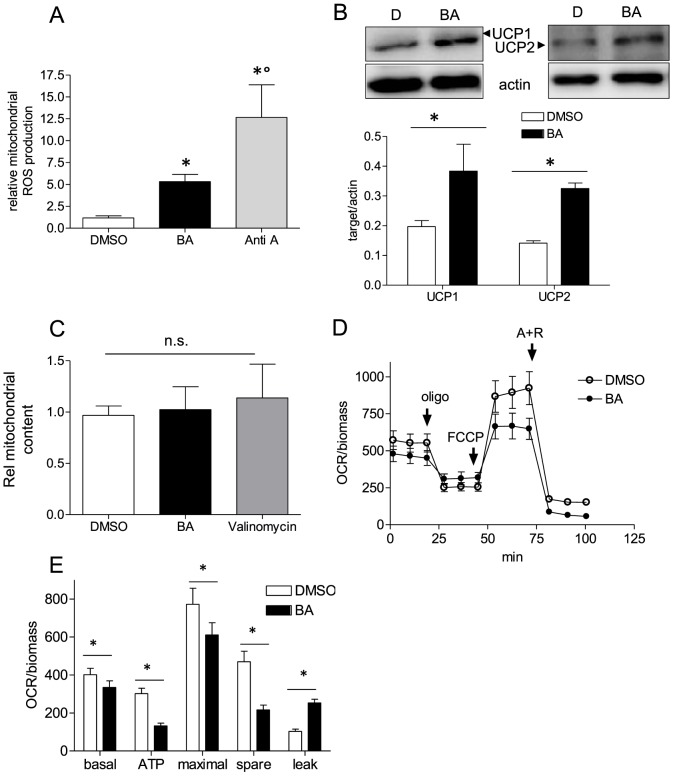
Mitochondrial function in the presence of BA.(A) MEF were treated with 10 µM BA or 0.1% DMSO for 16 h before they were subjected to flow cytometric analysis of the mitochondrial ROS production with the use of MitoSox Red and antimycin A (2 µM, 1 h) as positive control. (n = 3 (each in duplicate or triplicate); mean + SD,* p<0.05, t-test). (B) MEF were treated with DMSO or 10 µM BA for 16 h before total cell lysates were subjected to western blot analysis for UCP1, UCP2 (band at ∼25–35 kDa) and actin (42 kDa) as loading control. Representative blots of three independent experiments are depicted. The graph below depicts compiled densitometric values of UCP1/actin and UCP2/actin, respectively (n = 3; mean + SD; *p<0.05; t-test; DMSO vs BA). (C) MEF were treated with 10 µM BA or 0.1% DMSO for 16 h before they were subjected to flow cytometric analysis of the mitochondrial content by using MitoTracker Green. Valinomycin (200 nM, 16 h), a known disruptor of the mitochondrial membrane potential served as control for the potential-independent signal of MitoTracker Green. MEF were treated with 10 µM BA or DMSO (0.1%) for 16 h before they were subjected to a mitochondrial stress test as described under Materials. In (D) the mean oxygen consumption rate (OCR) of three independent experiments is depicted upon exposing cells successively to oligomycin (2 µM), FCCP (1.5 µM) and antimycin A + rotenone (A+R; 1+1 µM). In (E) those data are analyzed in terms of oxygen consumption rate under basal conditions, oxygen consumption for ATP synthesis, maximal respiratory rate, spare respiratory capacity and proton leak (mean + SD,* p<0.05, t-test, DMSO vs. BA).